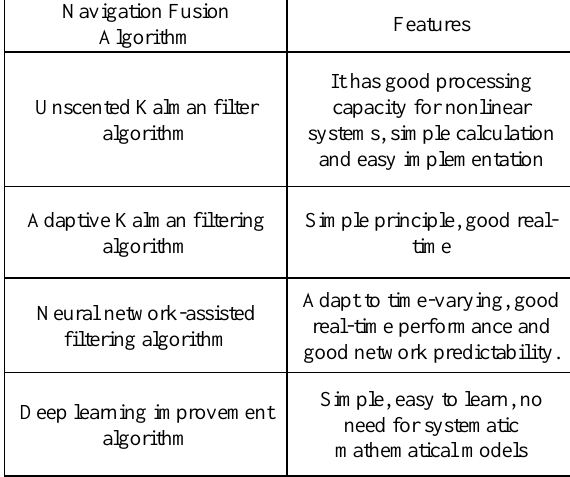
Table 2 . Four main improved navigation filtering algorithms. About integrated navigation filtering algorithm, there are many other improved algorithm, such as extended Kalman filtering algorithm, the optimal fixed interval smoothing algorithm, the improved adaptive algorithm, and artificial intelligence into the navigation filtering algorithm, such as radial basis function (RBF) neural network, neural network and high-order neural networks to predict GNSS failure when the position error of inertial navigation system.